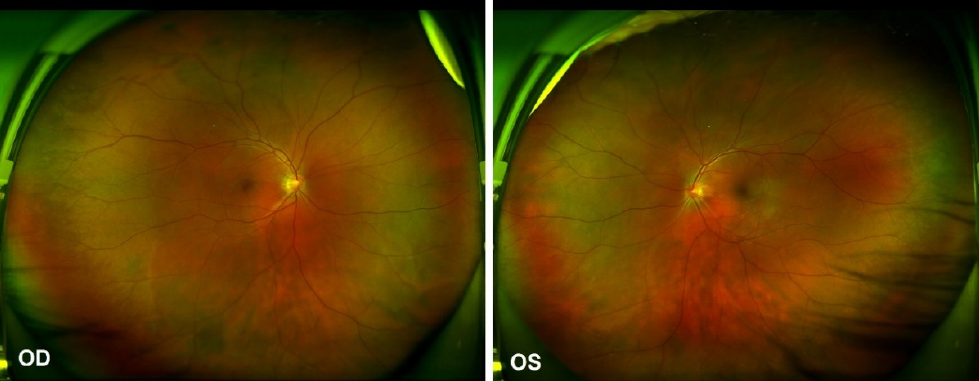
Figure 3. ( a ) OCT on 9 June 2021: Heidelberg optical coherence tomography (OCT): bullous serous retinal detachment, retinal pigment epithelium (RPE) undulation and membranous structure on the RPE beneath the foveal cystoid space. ( b ) Control OCT on 7 July 2021: total resolution of subretinal fluid, discontinuous inner segment/outer segment (IS/OS) layer and rough RPE. ( c ) Control OCT on 13 October 2021: further improvement in IS/OS layer and RPE, with a melanin change in the choroid stroma. ( d ) Control OCT on 20 December 2021 (the last evaluation): stable and similar to the previ ‐ ous follow ‐ up.